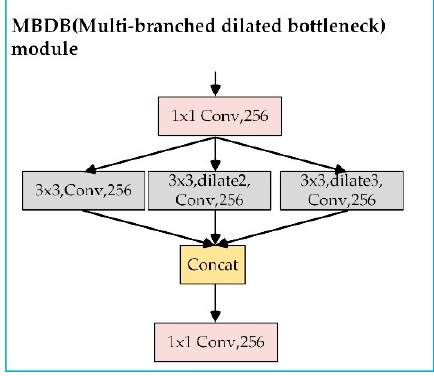
Figure 3. Multi-branched dilated bottleneck (MBDB) module.